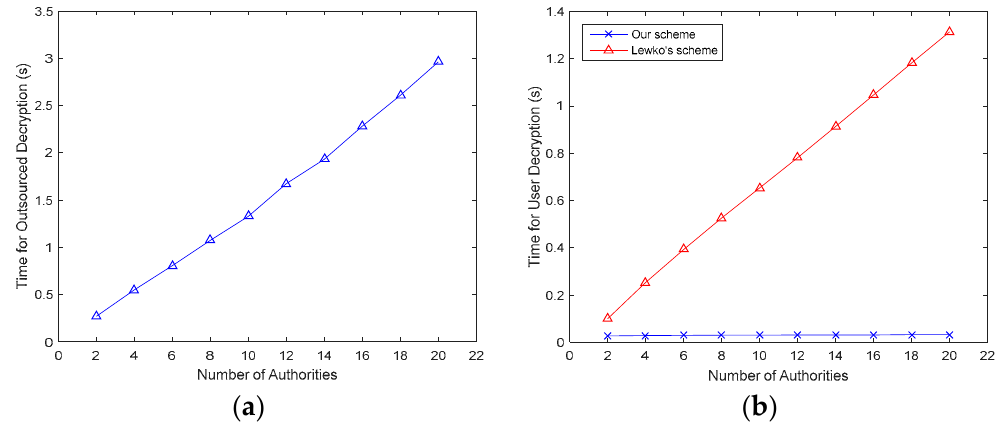
Figure 4. Comparison of decryption time with different number of authorities. ( a ) Decrypt_out time; ( b ) Decrypt_user time.